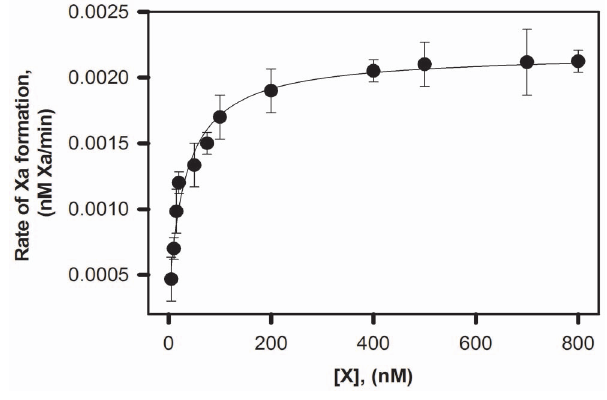
Figure 5. Michaelis-Menten kinetics of FX activation by FIXa in the presence of C6PS. The rate of activation of FX by FIXa in the presence of 400 m M C6PS, monitored at different concentrations of FX. Each test was performed in a buffer containing 50 mM Tris, 150 mM NaCl, and 5 mM Ca 2 + . The K M and k cat for this reaction are 33 nM and